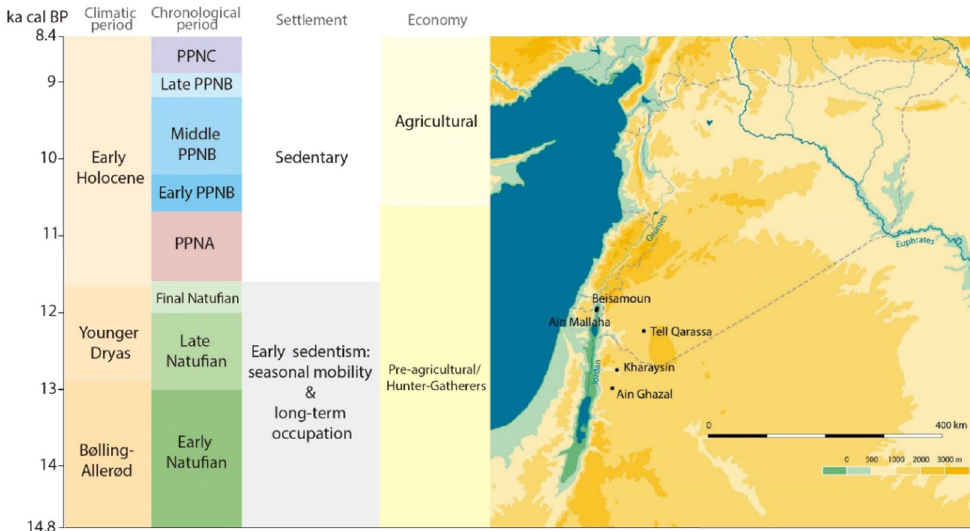
Figure 1. Left: correlation of the chronology (calibrated Before Present), climatic period, chronological period (culture), nature of settlement and economy during the Neolithic transition in the Southern Levant. PPN Pre- Pottery Neolithic. Right: Map locating the archaeological sites yielding human enamel samples serving for the analysis. We acknowledge Luis C. Teira for his Near East map (on the right). The figure was generated using Adobe Illustrate CC 2019 (https:// www. adobe. com/ cn/ produ cts/ illus trator.